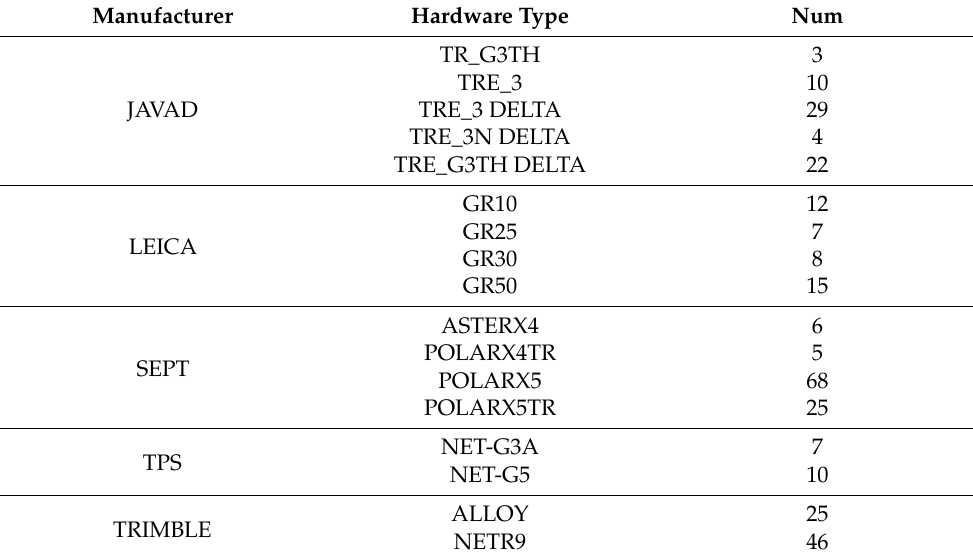
Table 1. Receiver types and the corresponding numbers.